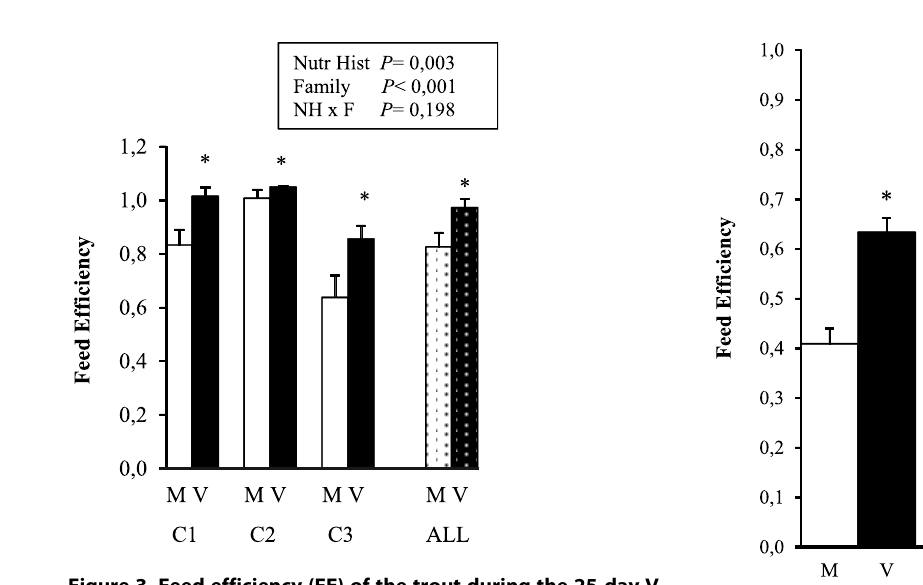
Figure 3. Feed efficiency (FE) of the trout during the 25-day V- challenge according to the early nutritional history (M or V) and family (C1, C2, C3). Values are means 6 SEM (n=4, except for C3M and C1V with n=3). Dotted bars represent the effect of nutritional history (M or V) during the V-challenge, averaged over all three families (ALL, means 6 SEM, n=11). The significance of the effects of nutritional history, family (C2=C1 . C3) and their interaction (2-way ANOVA) is provided in the figure. * indicates a significant effect of nutritional history (V . M, p , 0.05).